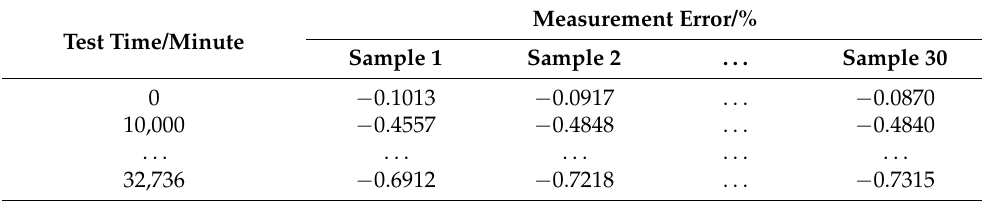
Table 2. Degradation of the measurement error of the meter.